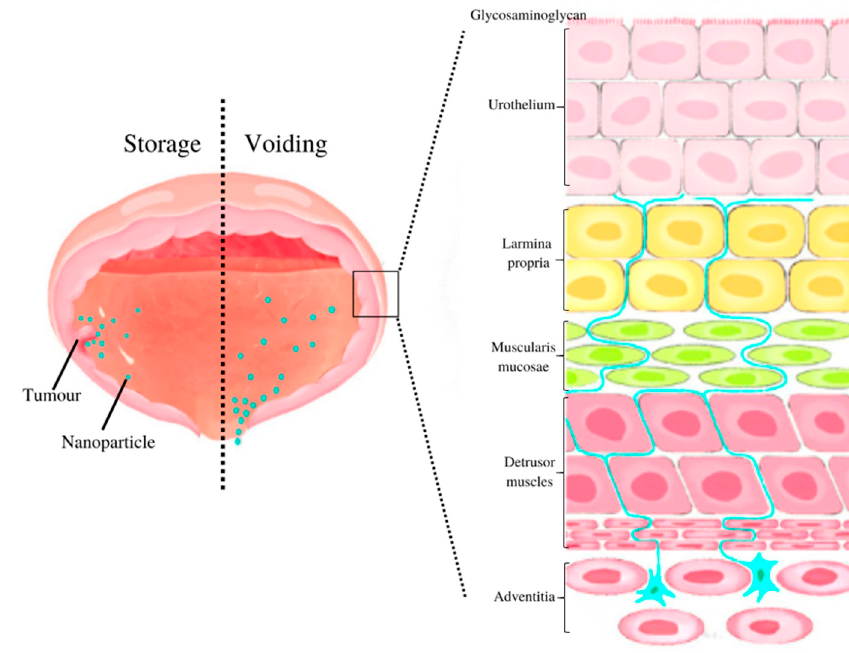
Figure 1. Bladder wall anatomy.